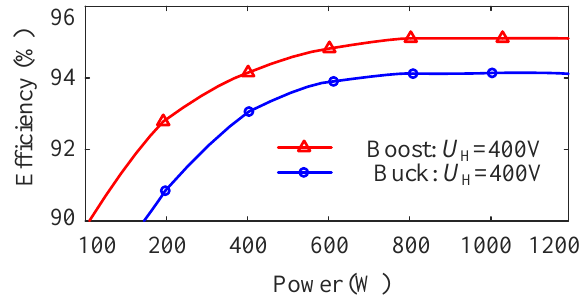
Figure 13. The efficiency curves. Figure 13. The e ffi ciency